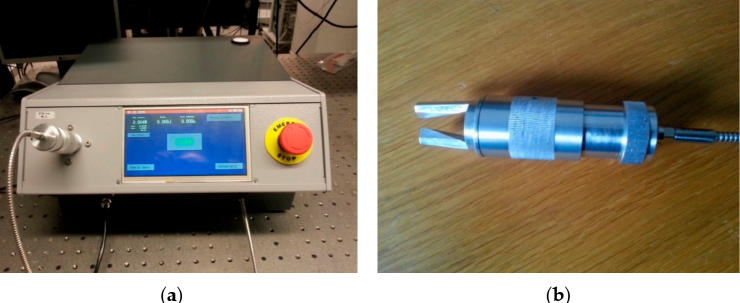
Figure 2. ( a ) The complete blue laser source with a touchscreen, which allows for setting the treatment parameters. A foot pedal is connected at the bottom (black cable). ( b ) The handpiece (applicator) at the end of the fiber. This applicator is inserted into the power meter in the photo on the left.